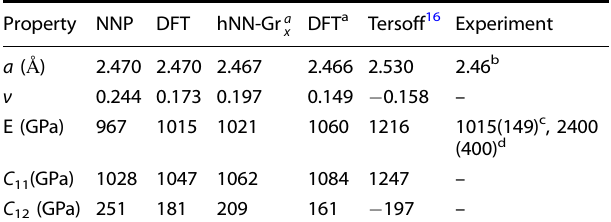
Table 4. Elastic properties of graphene. Property NNP